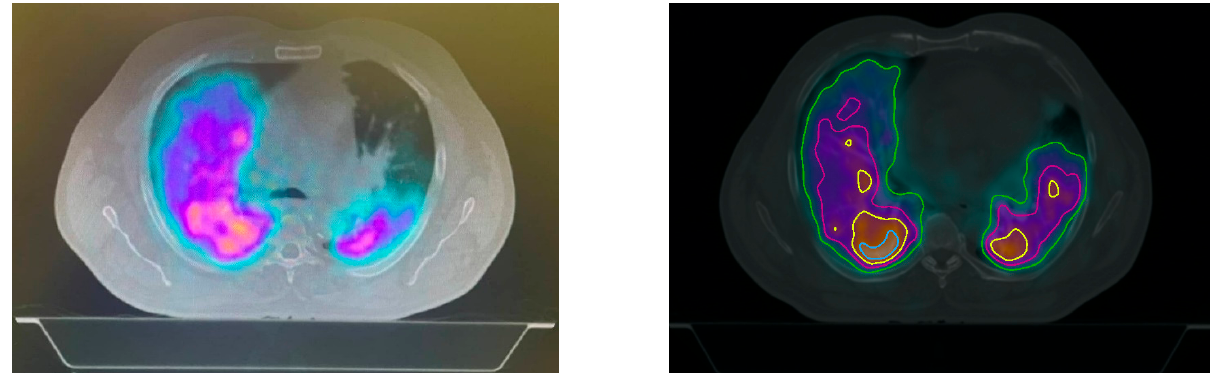
Figure 1. Deformable co ‐ registration between CT simulation images and the SPECT/CT.